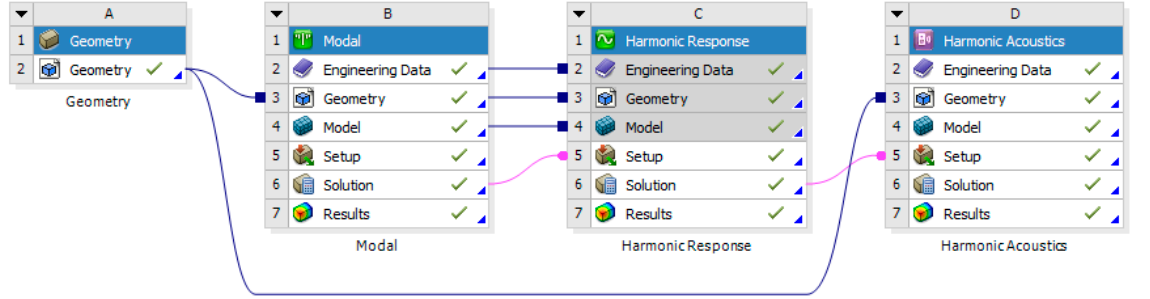
Figure 7. FEA project schematic.